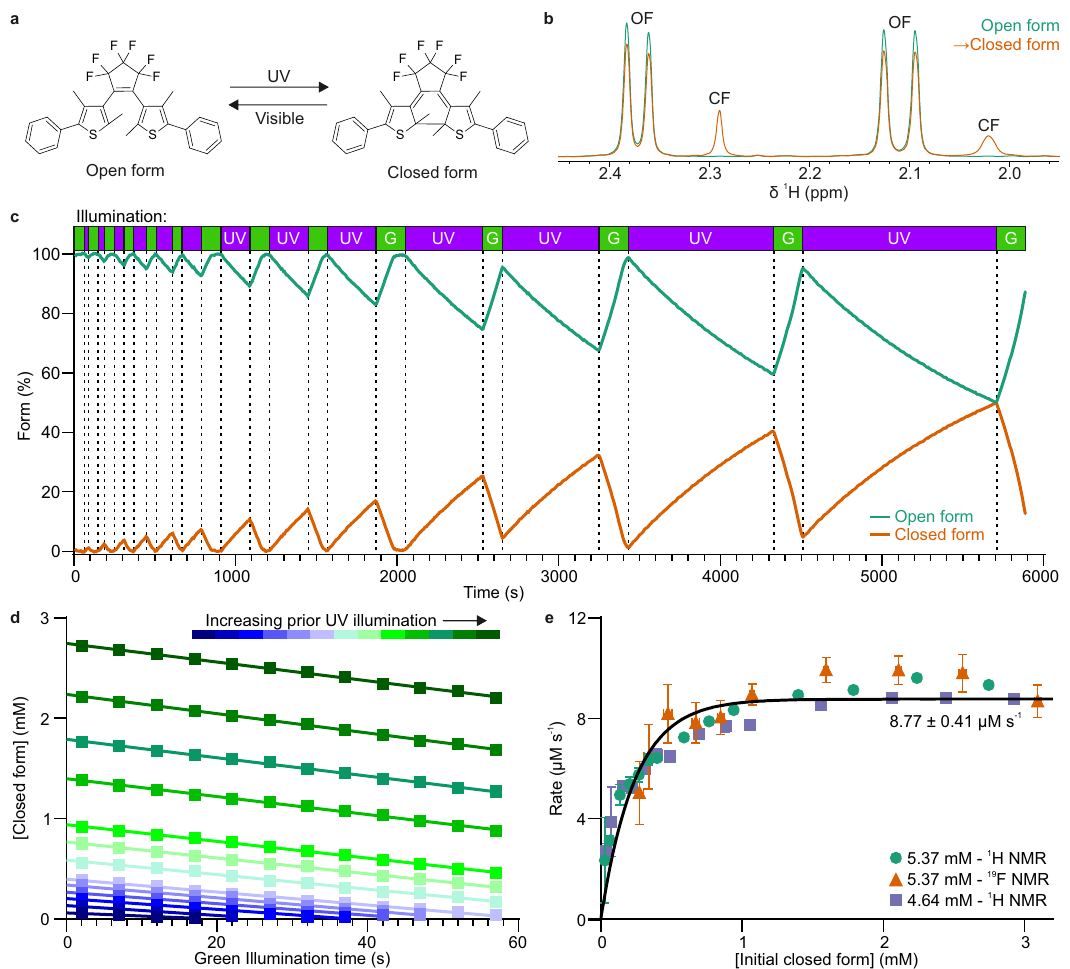
Fig. 4 Actinometry using reversible in situ photoisomerisation of DAE with two LEDs. a Schematic of DAE photoisomerisation, with the observed actinometric reaction being the conversion from closed (CF) to open form (OF) under visible light. b Appearance of characteristic OF and CF DAE 1 H NMR signals. c DAE photoisomerisation assessed by 1 H NMR under repeated cycles of UV (280 nm) and lime green (550 nm) light illumination. d Determination of initial rates of isomerisation by linear fi ts to DAE CF concentration under green light illumination, with increasing prior UV illumination. e Initial rates of DAE photoisomerisation under green light derived from 1 H and 19 F NMR spectroscopy. The error bars and estimated fi tting errors represent 95% con fi dence